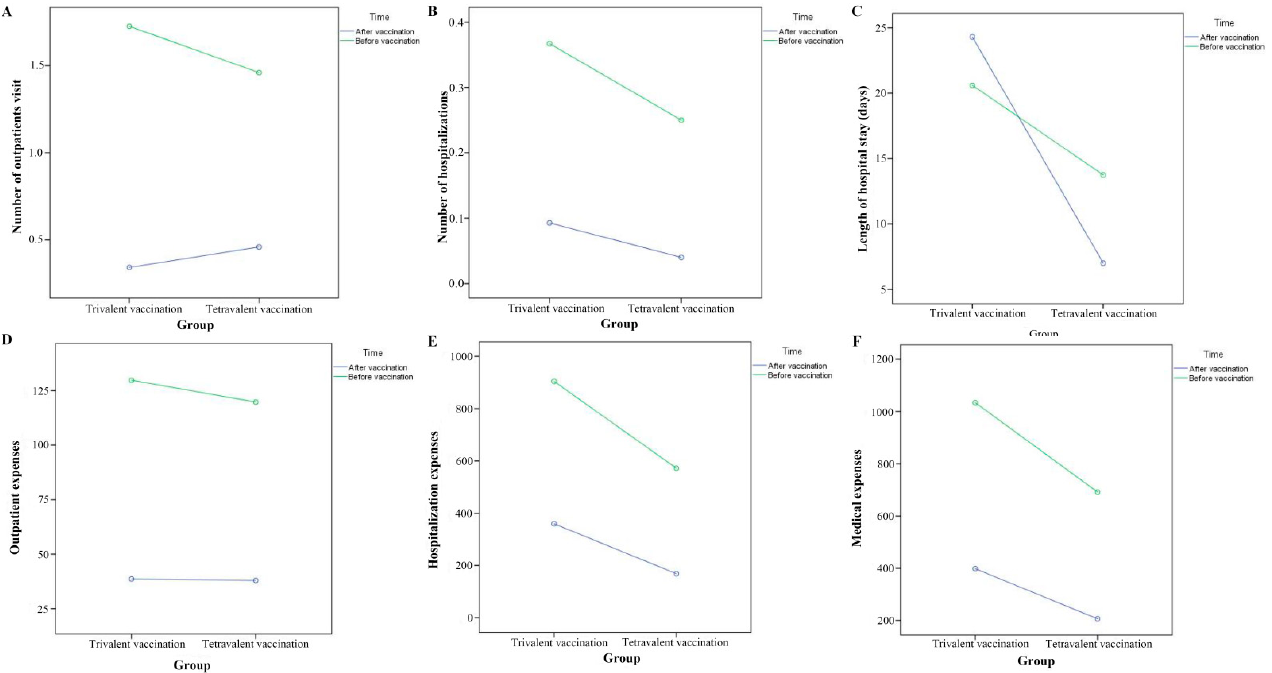
Figure 1. The variation in number of outpatient visits, the number of hospitalizations, the total medical cost of patients, outpatient expenses, hospitalization expenses, and the length of stay of patients before and after influenza vaccination among two groups. ( A ) number of outpatient visits; ( B ) number of hospitalizations; ( C ) length of hospital stay; ( D ) outpatient expenses; ( E ) hospitalization expenses; ( F ) total medical cost.